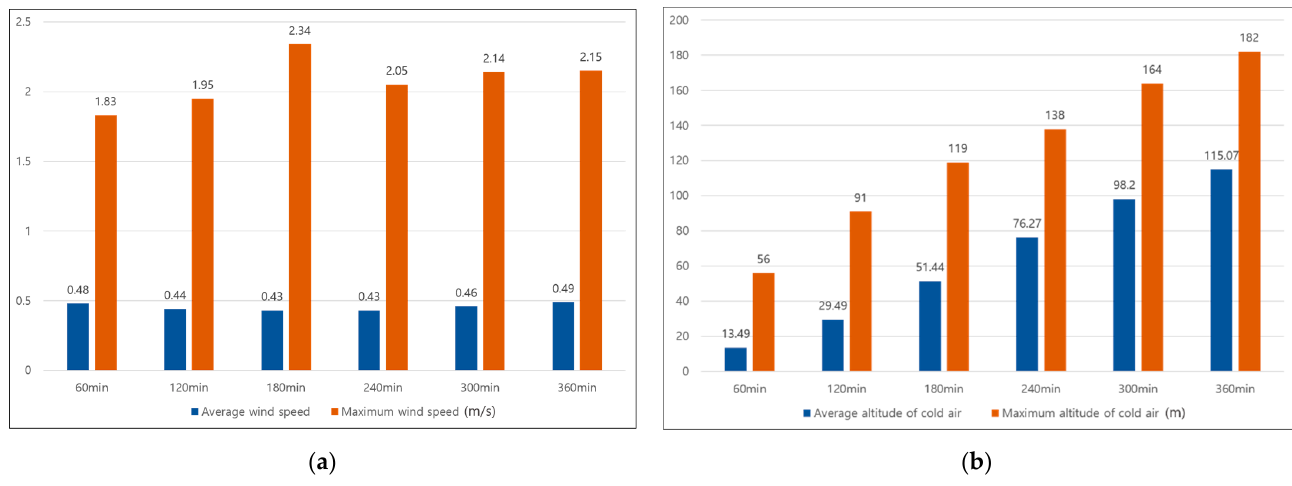
Figure 10. Comparison of cold-air properties by minute after the start of cold air generation: ( a ) changes in cold-air wind speed by time; ( b ) changes in cold-air layer height by time.